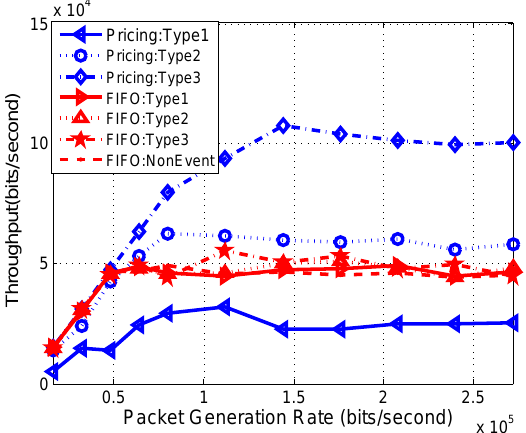
Figure 12. Throughput of multiple types of packets for chain